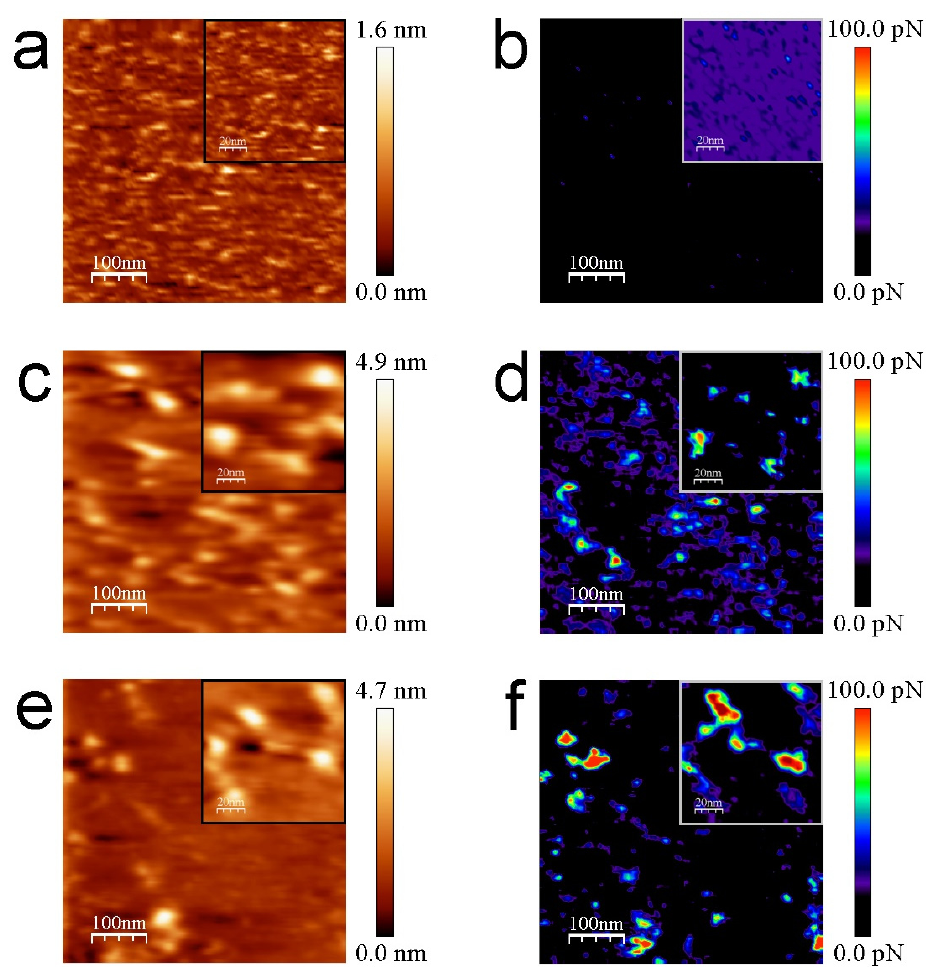
Figure 4. Representative molecular recognition images for thiols ( a , b ), avidin ( c , d ), and streptavidin films ( e , f ). Topography ( a , c , e ) and simultaneous adhesion ( b , d , f ) maps of the aforementioned layers provided with biotinylated tips. The inset figures represent the magnification of the studied thiol/strept(avidin) samples. Scan sizes are 500 nm × 500 nm for the bigger images and 100 nm × 100 nm for the insets.